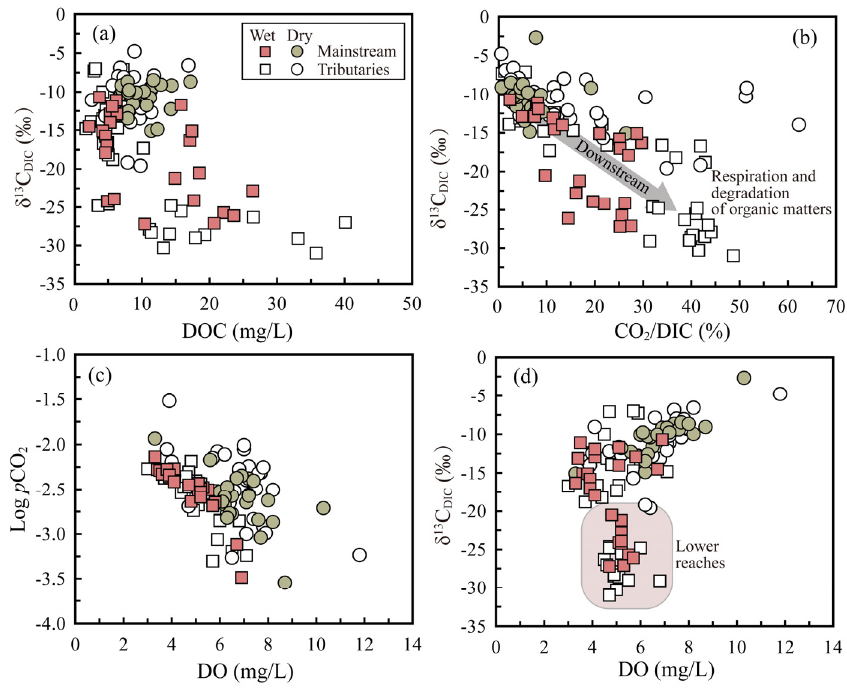
Figure 6. Plot showing the relationship between δ 13 C DIC values and DOC concentrations ( a ), δ 13 C DIC values and CO 2 /DIC ratios ( b ), Log p CO 2 and DO concentrations ( c ), and δ 13 C DIC values and DO concentrations ( d ).